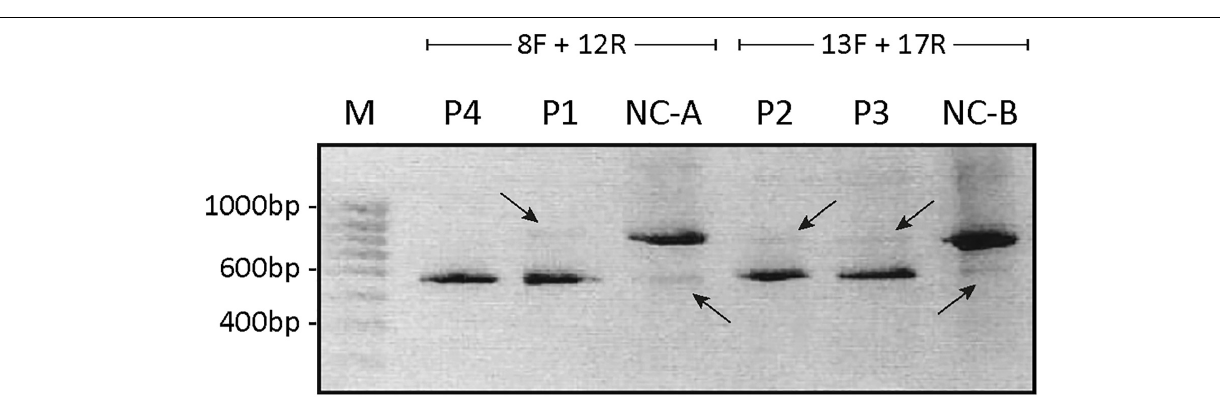
FIGURE 2 | Agarose-gel of separated PCR fragments. The cDNA fragment spanning from exon 8 to exon 12 was PCR amplified from persons P1, P4, and control (NC-A) using primers 8F and 12R, and the cDNA fragment from exon 13 to exon 17 was PCR amplified from persons P2, P3, P5, and control (NC-B) using primers 13F and 17R. The PCR products were separated on a 1% agarose gel. The bands were purified and Sanger sequenced. The estimated size of the amplified fragments is indicated. A 100-bp ladder (M) was used as reference. Intense bands representing ATP7A mRNA without exon 10 in P1 and P4 and representing ATP7A without exon 15 in P2 and P3, respectively, are shown. Only very faint bands representing ATP7A wild-type fragments are observed in P1, P2, and P3 (indicated by arrows pointing down). In the two NC samples, intense bands representing wild-type transcripts are observed in addition to very faint bands representing ATP7A mRNA without exon 10 (NC-A) or without exon 15 (NC-B), respectively (indicated by arrows pointing